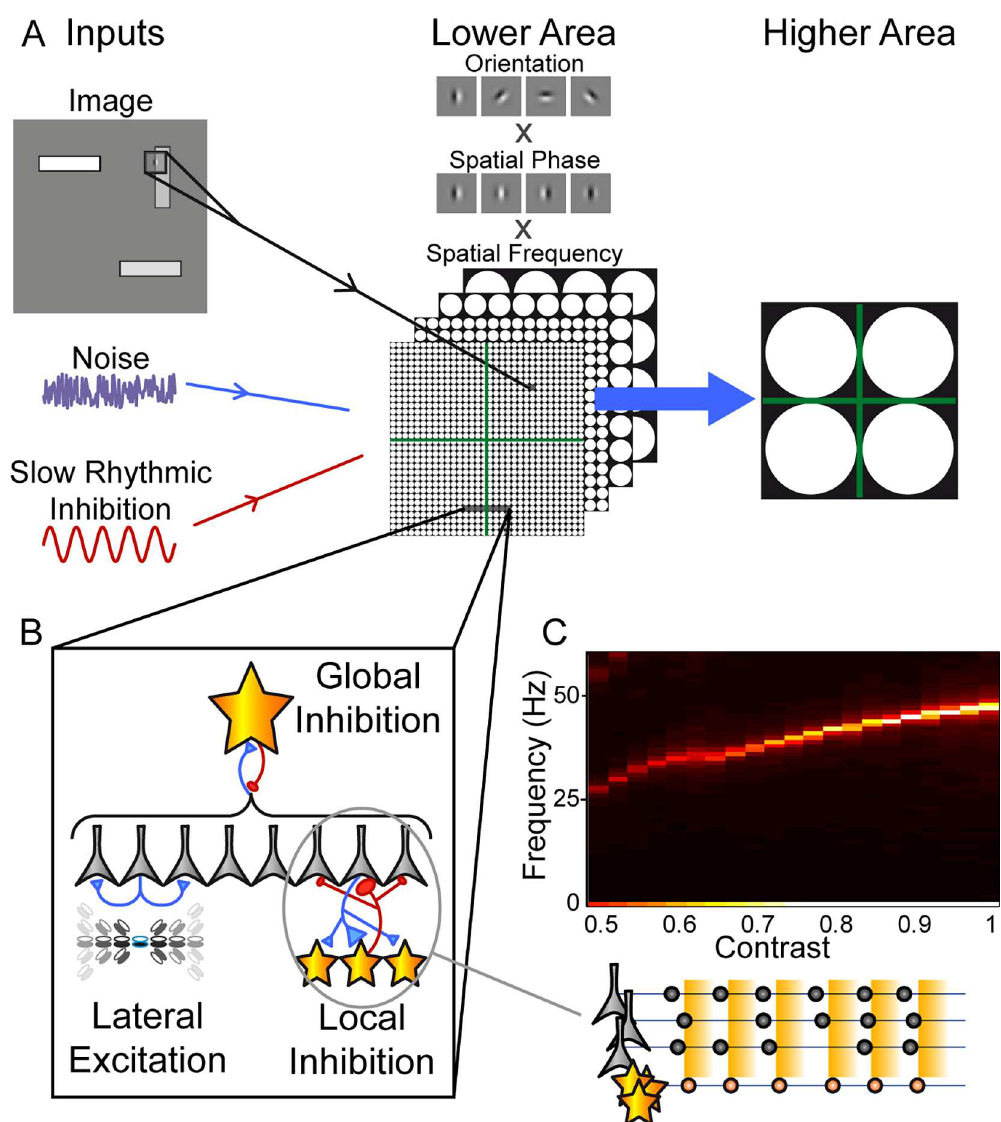
Fig 2. The network model. A. The model comprises two areas: a lower area approximating primary visual cortex, composedof multiple retinotopically arranged‘simple cell’ layers duplicatedacross orientation,spatial phase and spatial frequency tuning. For input, these cells received a visual stimulus (excitatory conductance driven via an appropriate Gabor filter), noise (independent across cells) and a common slow rhythmic inhibitory conductanceto mimic an alpha/theta oscillation (9 Hz in all of our simulations). In turn, the lower area sent convergent connections to a simplistic higher area, comprised in this case of just 4 cells, each receivinginput from one retinotopicquadrant of the lower area (i.e. pure spatial selectivity). B. Within each area, a number of local circuit mechanismscould be implemented: lateral excitation (see Methods for details); local inhibitionwith a 2-D Gaussian distributionof synaptic strength both to and from a layer of inhibitoryinterneurons; and global inhibition implemented via a single interneuron receivinginput from and sending output to all the excitatory cells in the lower area. In the simulations reported, local excitation and inhibition were always included,whereas global inhibitionwas varied as an important parameter determining network behaviour. C . The power spectrum of activity generatedin the lower area in response to a single stimulus object (light rectangle, 9 x 39 pixels, with a single-pixel dark outline) as a function of its contrast, calculated for the PSTH of all activated cells (10 repeats of 1 second of activity for each contrast level tested; note that no global inhibitionwas includedin these simulations). The network readily generates gamma frequencyactivity, via a PING mechanism as illustrated diagrammatically below the plot (pyramidalcells and their times of firing shown in gray; inhibitoryinterneurons in orange; the orange rectangles in the backgroundrepresent the time course of inhibitoryfeedback). The frequency of gamma activity is contrast dependent, matching experimental